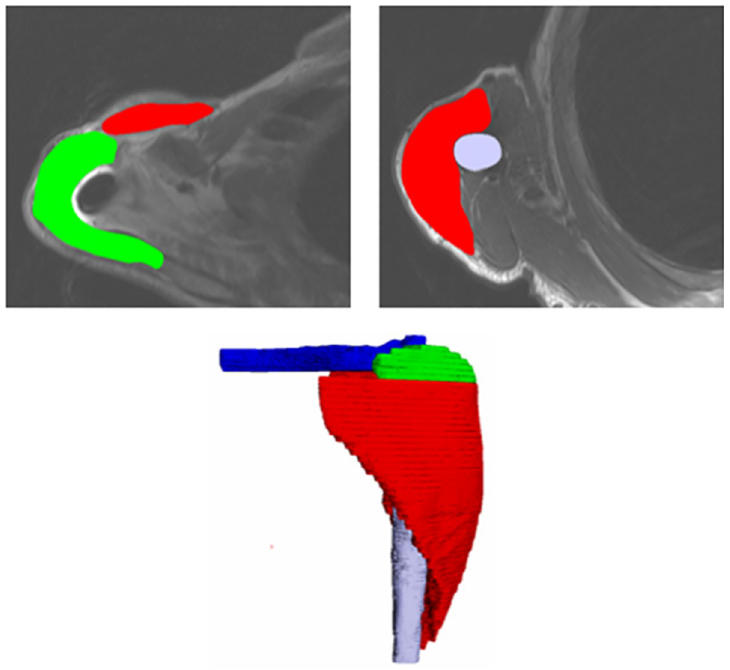
Fig 1. Manual segmentation of the slices and 3D modeling with SliceOmatic ™ software. In Green: acromion; in Red: deltoid; in Blue: clavicle; in Grey: humeral diaphysis.